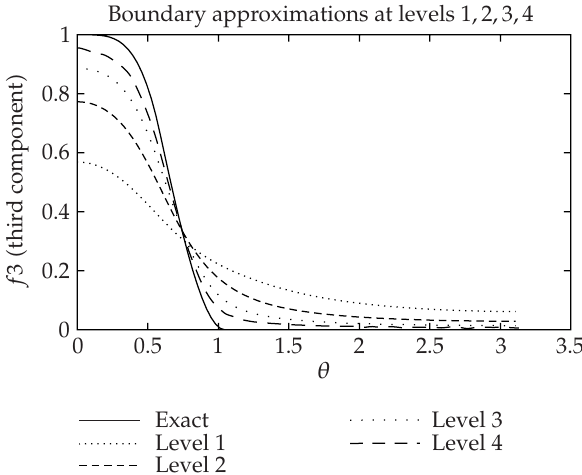
Figure 6.2 . Sectional illustration of the scale approximations of f ( third component ) associated to the Ω -scaling function Φ ( 5 )